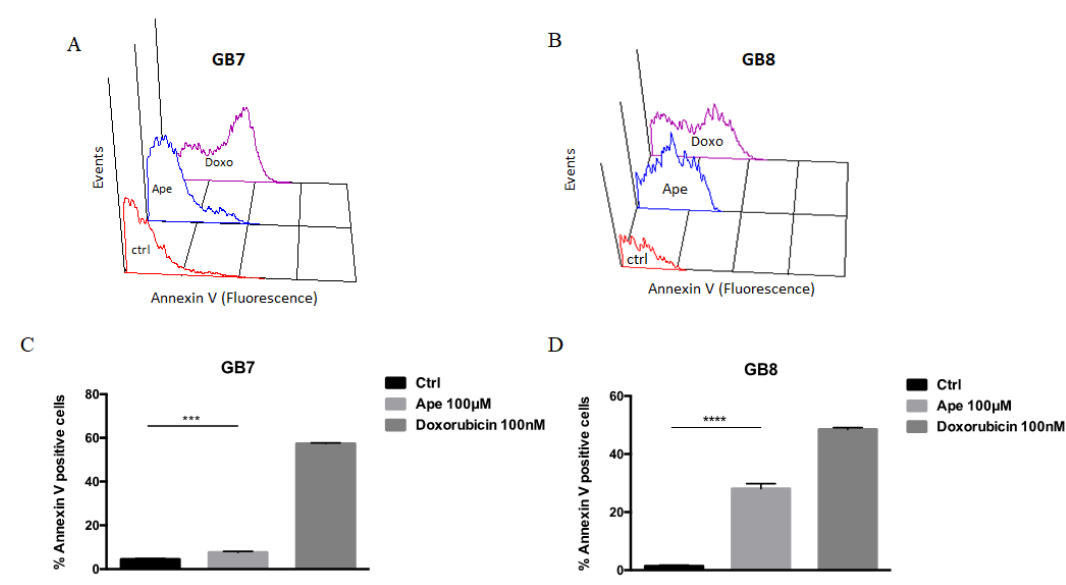
Figure 7. Distribution diagram of Annexin V expression in GB7 ( A ) and GB8 ( B ) cells. Percentage of Annexin V positive cells in GB7 ( C ) and GB8 ( D ) cultures after 100 μM APE treatment. Doxorubicin (100 nM) was used as a positive control. (t-test; APE 72 h vs Crtl *** p < 0.001; **** p < 0.0001). The data are the average ±SEM of three independent experiments.